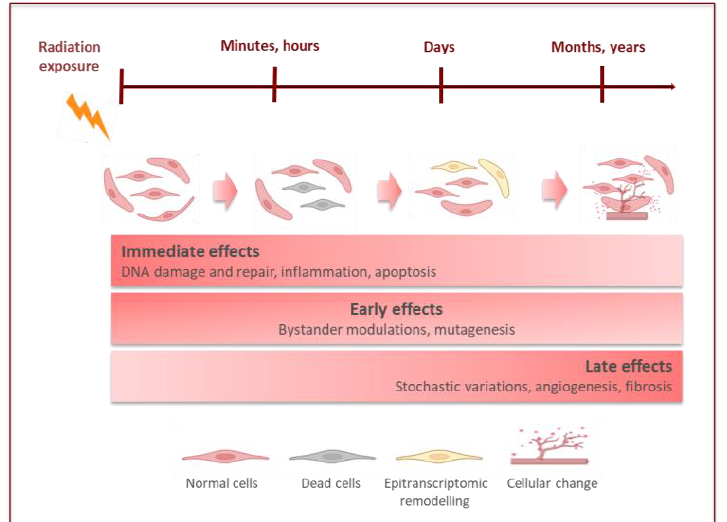
Figure 2. Onset of radiation-induced effects at cellular and tissue levels. Immediate radiation effects lead to signaling events such as DNA damage and repair mechanisms, tissue inflammation, and apoptosis (left). Moreover, radiation is associated with bystander effects (biological effects expressed by non-irradiated cells through signals produced by the irradiated area) and (epi)genomic modulations (middle). The cellular epigenetic modifications can trigger particular circuits after radiation exposure (right). (Created with